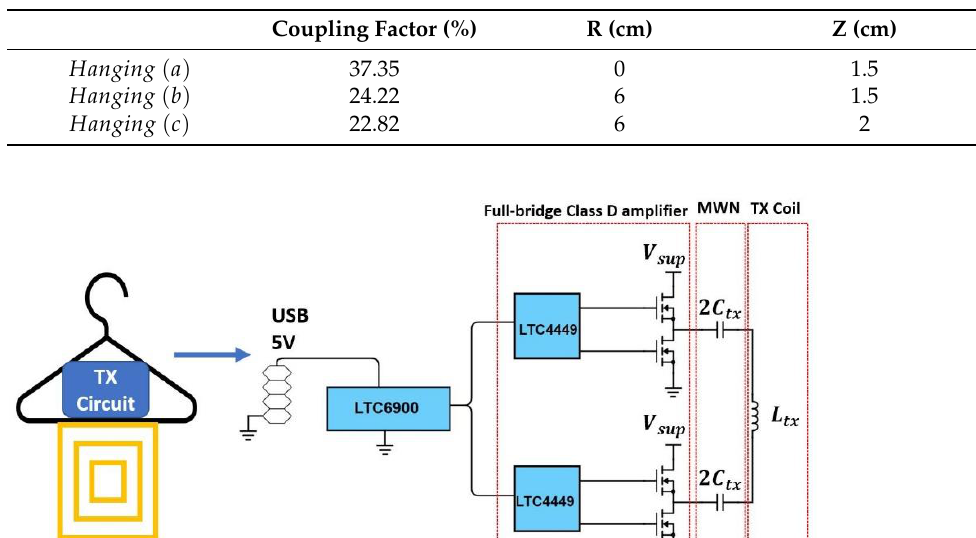
6 of 21 Table 1. Properties of individual coils in the embroidered RX coil array. Coil